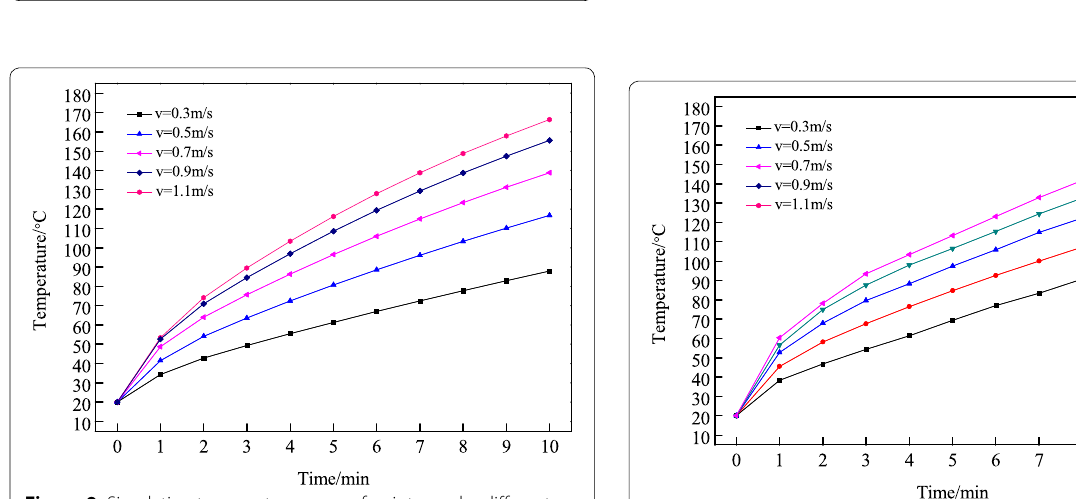
Figure 10 Time and pressure values when the roll surface temperature was heated to 200 °C under different velocities 1.1 m/s =